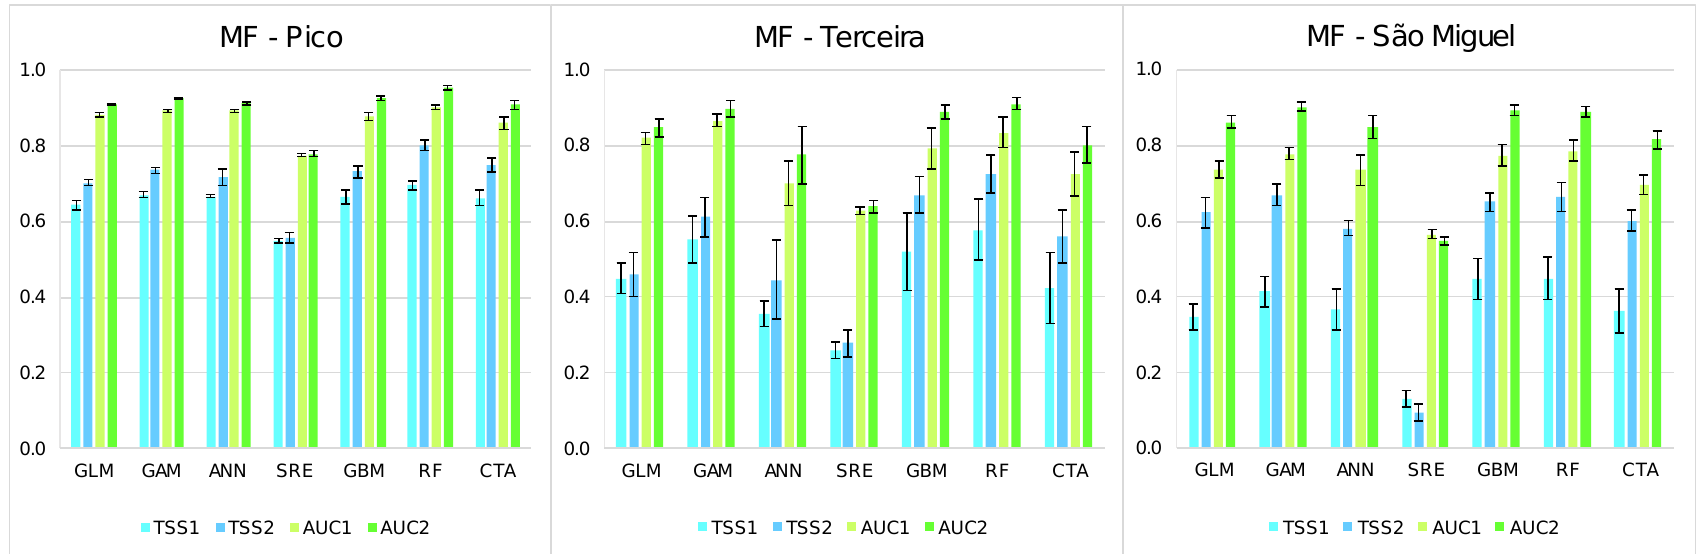
Figure 6. Evaluation of M. faya (three distinct islands) distribution models/algorithms (mean values) by the true skill statistic (TSS) and the receiver operating characteristics curve (AUC), using two different EGV sets: EGV set 1 (climatic variables) and EGV set 2 (climatic and topographic variables). The models/algorithms were: GLM (generalized linear models), GAM (generalized additive models), ANN (artificial neural networks), SRE (surface range envelope), GBM (generalized boosted regression models), RF (random forest), and CTA (classification tree analysis). TSS1: TSS of EGV set 1; TSS2: TSS of EGV set 2; AUC1: AUC of EGV set 1; AUC2: AUC of EGV set 2. Error bars correspond to the standard deviation. For more details, see Supplementary Material Tables S1 – S3.